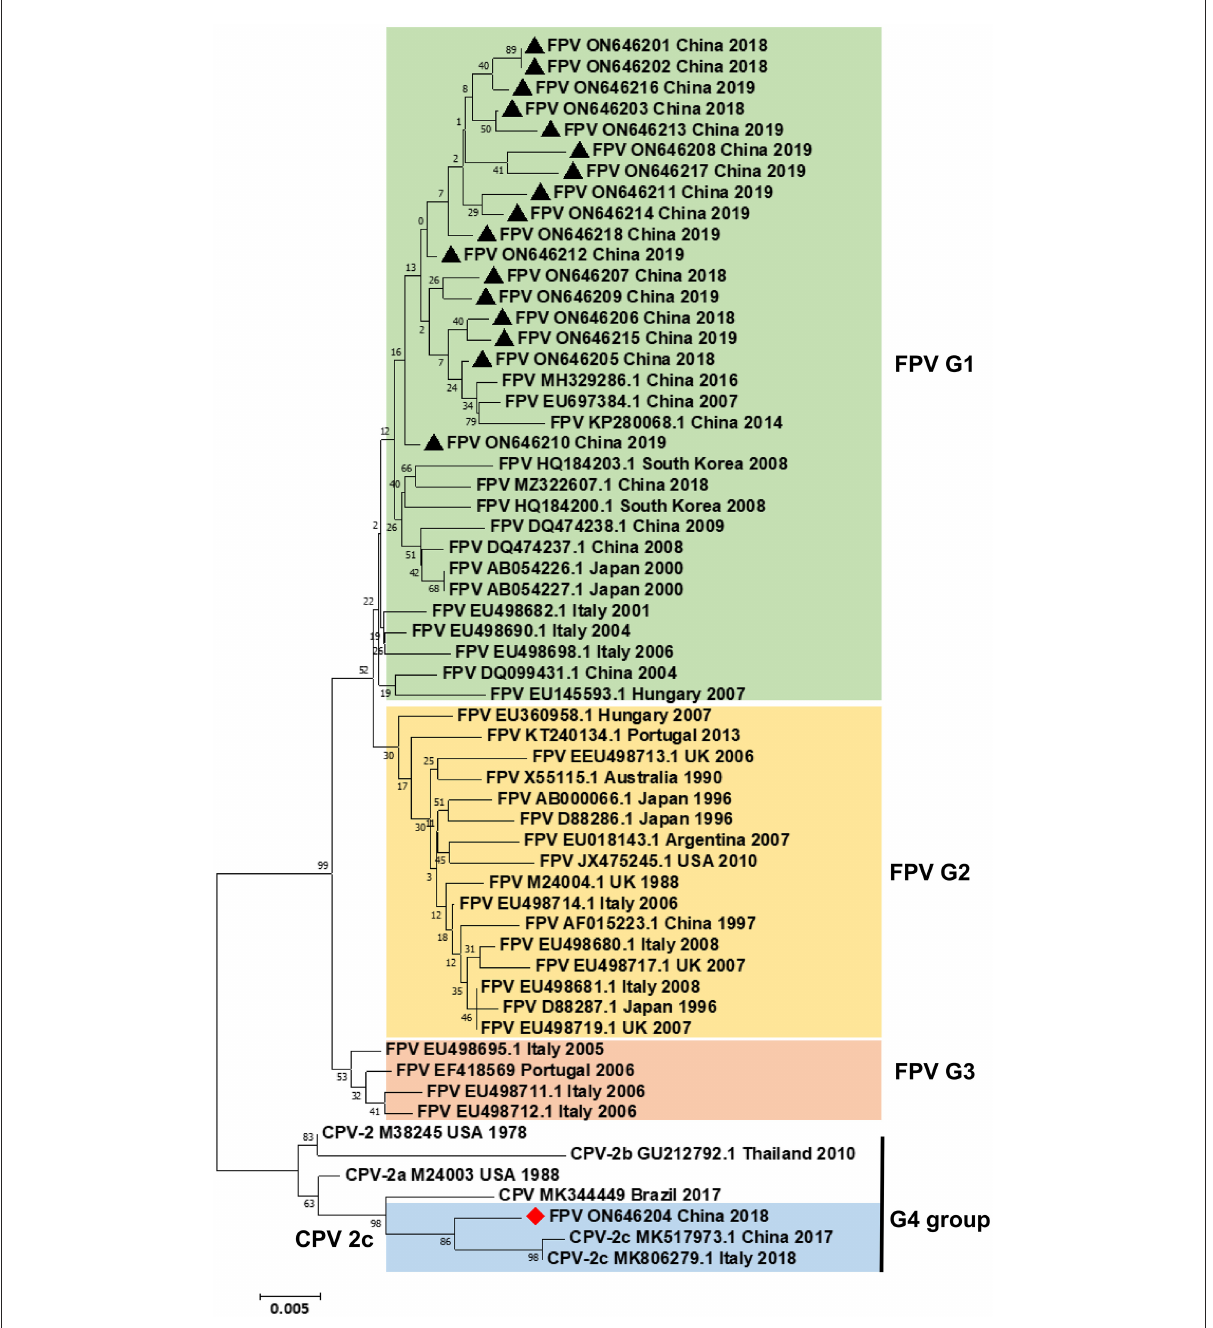
FIGURE1 Phylogenetic tree analysis. A phylogenetic tree based on 18 VP2 gene sequences from domestic cats and 41 reference FPV/CPV strains was constructed by the maximum likelihood method using the MEGA software, version 5.1 (http://www.megasoftware.net/). N indicates the FPV strains in this study. (cid:7) indicates the FPV DL04 strain. Horizontal branch lengths are proportional to genetic distances. Scale bars indicate nucleotide substitutions per site. Bootstrap values were calculated based on 1,000